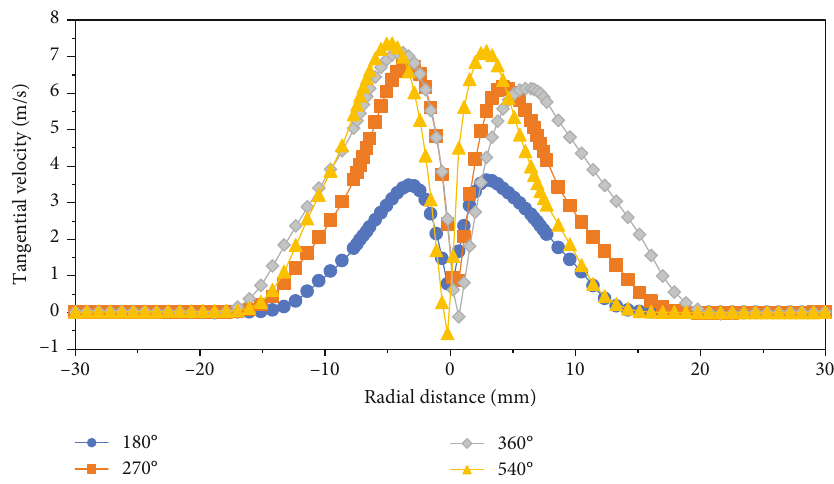
Figure 14: Tangential velocity distribution of di ff erent spinning angles in h / d = 8